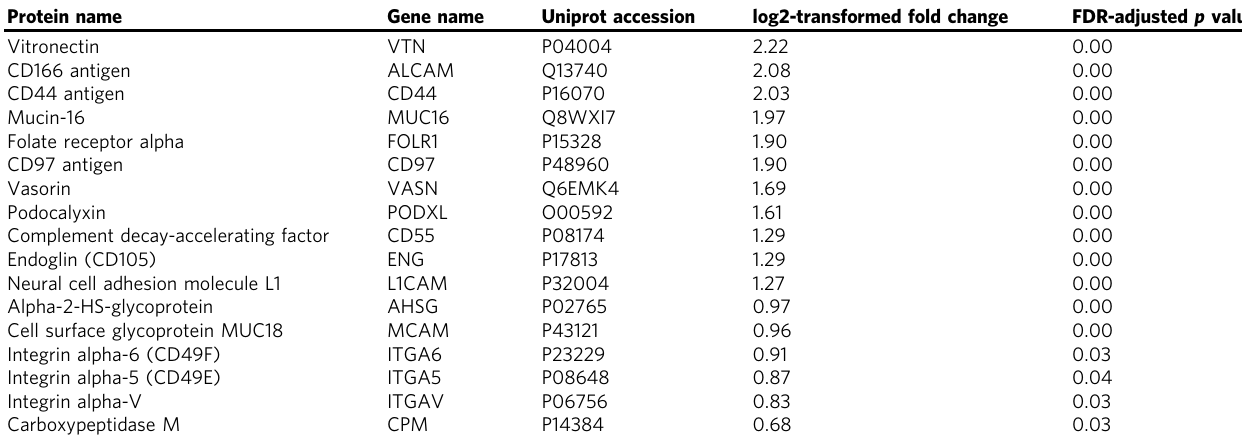
Table. 1 Folate-receptor candidates identi fi ed using folate-based